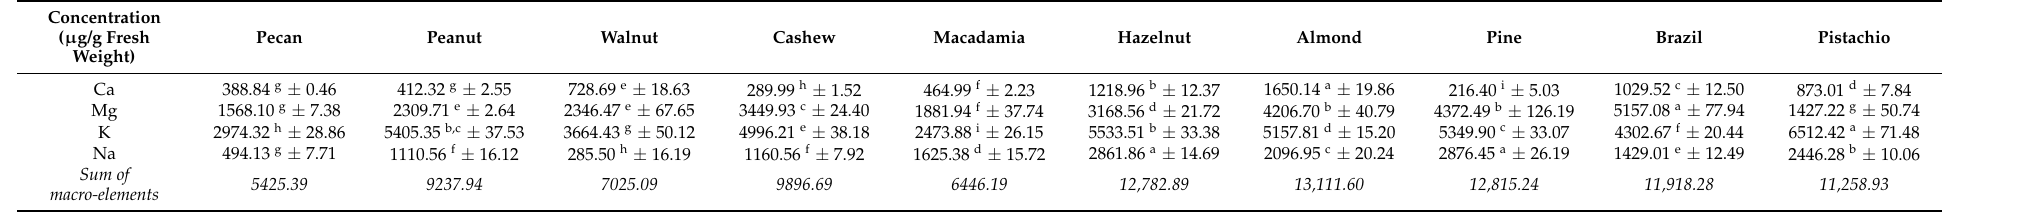
Table 3. The content of macro-elements in nuts.